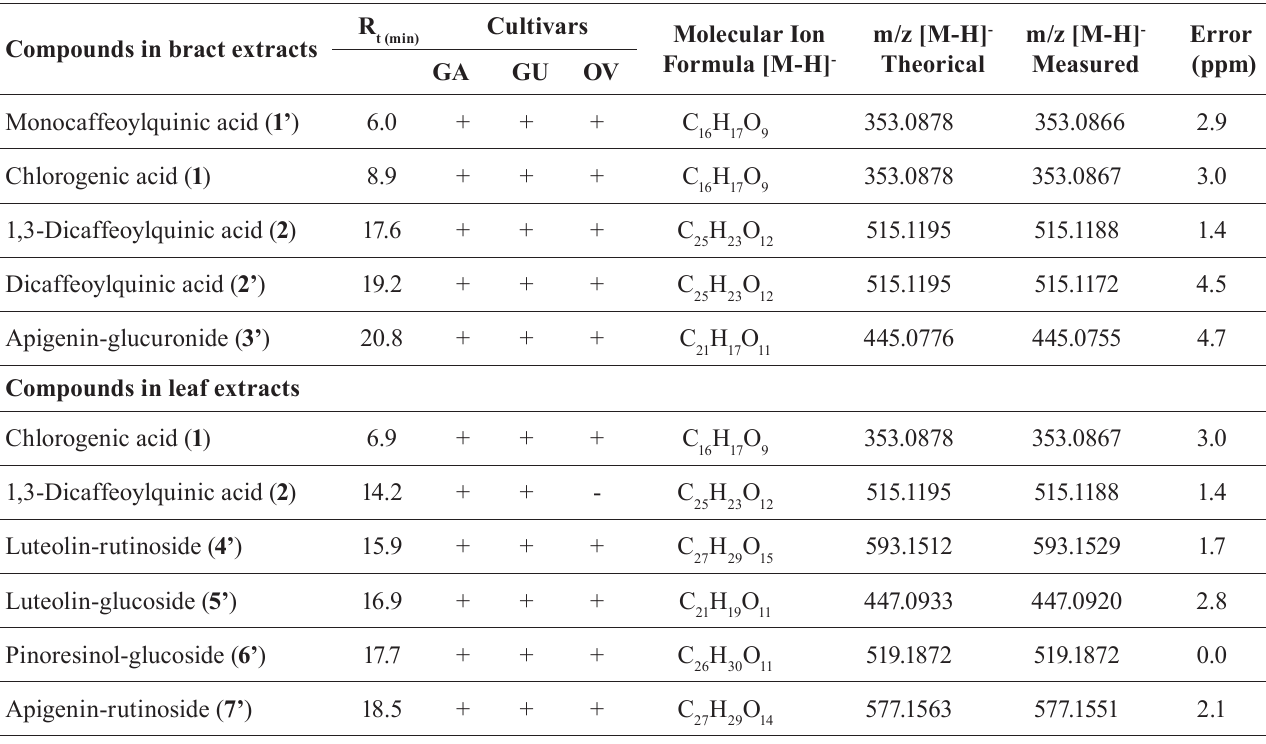
TABLE I - C ompounds detected by LC-HRMS in bract extracts and leaf extracts of Gauchito (GA), Gurí (GU) and Oro verde (OV) cultivars R t Compounds in bract extracts